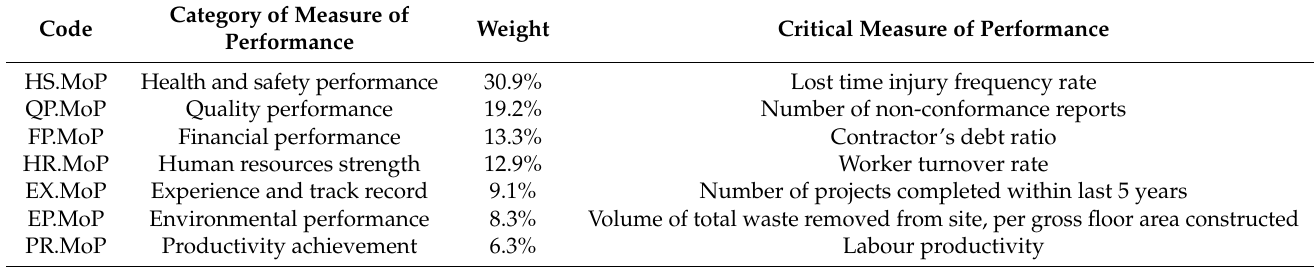
Table 8. Performance model